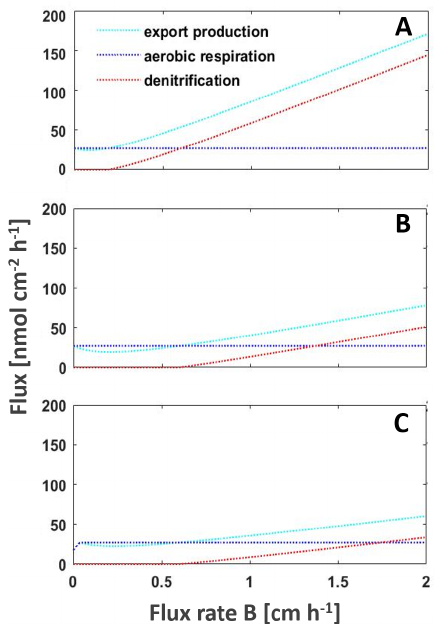
Figure 4. Model of the main processes export production, aero- bic respiration, and denitrification shaping the intensity of the BoB OMZ to changing nutrient fluxes from riverine, land, or atmospheric inputs or upwelling to increased upwelling, with (a) current nutrient loads (b) decreasing nitrate concentrations by 32% as predicted by Gregg et al. (2019) and (c) with both decreased nitrate concentra- tions and decreased nutrient fluxes from deeper waters as a result of warming-dependent increased stratification. The model is adapted from Boyle et al. (2013).